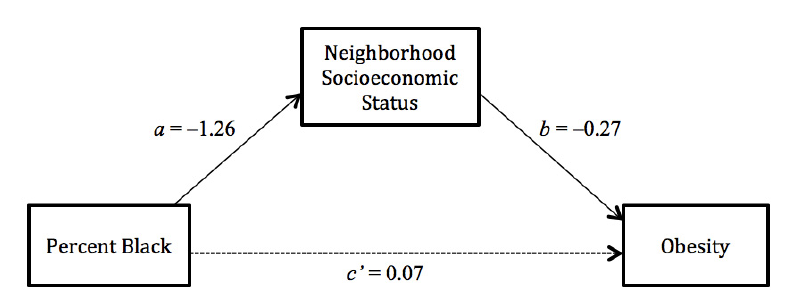
Figure 2. Path diagram depicting neighborhood SES as the mediator between black concentration and obesity among white